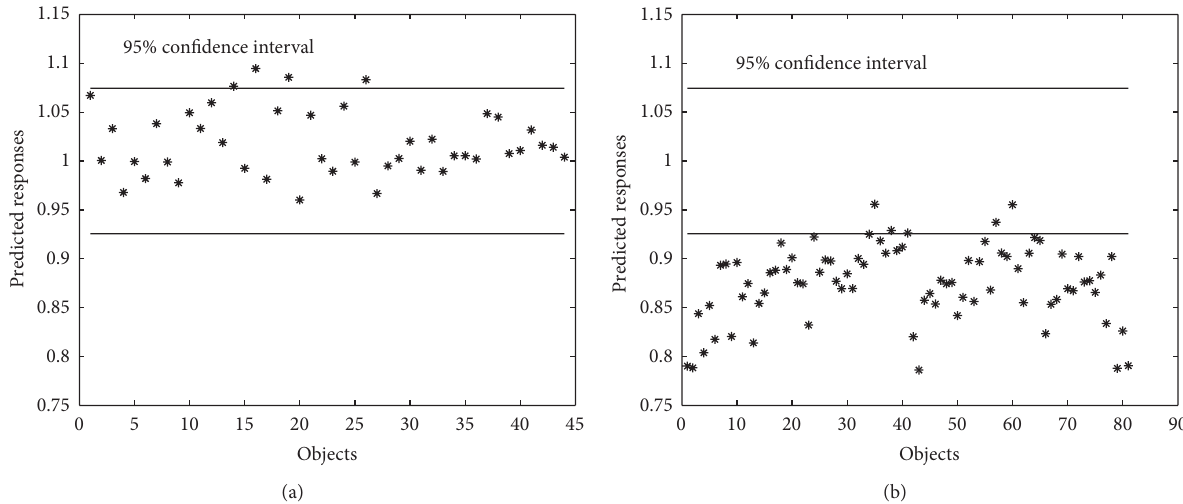
F 4: Results obtained by SNV-OCPLS with 8 latent variables for (a) 44 positive test objects, and (b) 81 negative test objects.